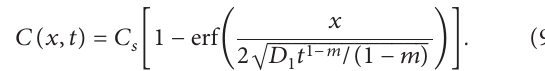
Figure 5: Effect of different ions on diffusion coefficient of SO 42 − in CGBM. (a) Na MgSO 4 +5% NaHCO 3